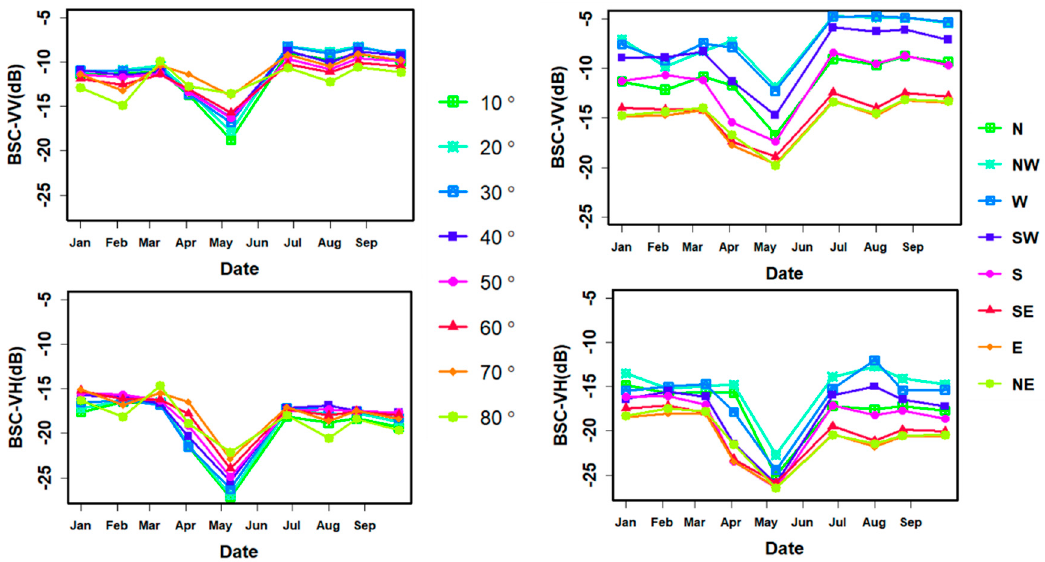
Figure 17. Mean backscattering intensity of VV ( top ) and VH ( bottom ) polarization in the Swiss Alps during 2018 for different slope ( left ) and aspect ( right ) terrain classes.